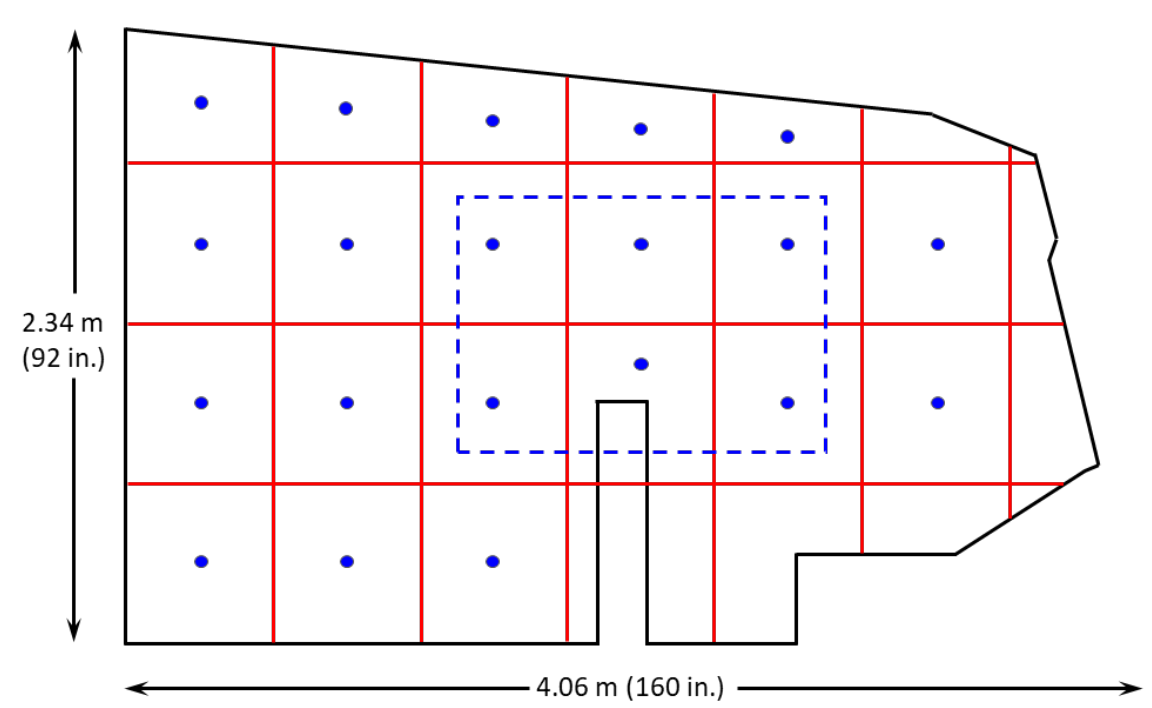
Figure 6. Cross-section of the longwall panel (not to scale) with 0.61 m x 0.61 m grid and measurement points. For the first stage comparison, the quantity of air passing through each cross-section was calculated as the product of the area-weighted average velocity and the total area of the cross-section. The experiment was repeated for all four cross-sections with three different percentages of maximum fan speeds: 0% (scrubber fan turned off), 50%, and 100%. The face-air quantity was always kept constant at 23.23 m 3 /s (49,200 cfm). See Table 2 for the results of the air quantity through different cross-sections at different scrubber capacities. For the second stage comparison, six points from each cross-section were picked. The points were located inside the blue, dashed-line rectangle at the center of each cross-section, as shown in Figure 6. Table 3 presents the velocities at six points for each of the four cross- sections at 0%, 50%, and 100% scrubber fan capacities. The data inside the red, dashed-line rectangle in Table 3 are examples of velocities at six points for cross-section number 2 at 50% scrubber fan capacity. Table 2. Results of air quantity survey showing quantity through different cross-sections for different scrubber fan